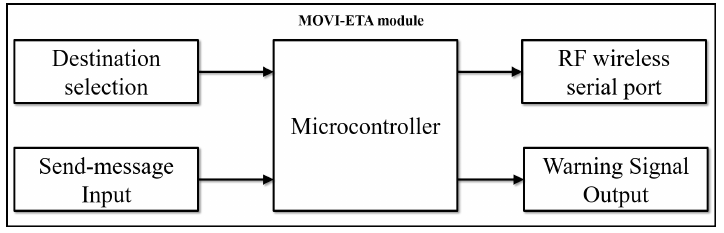
Figure 2. MOVI-ETA block diagram.